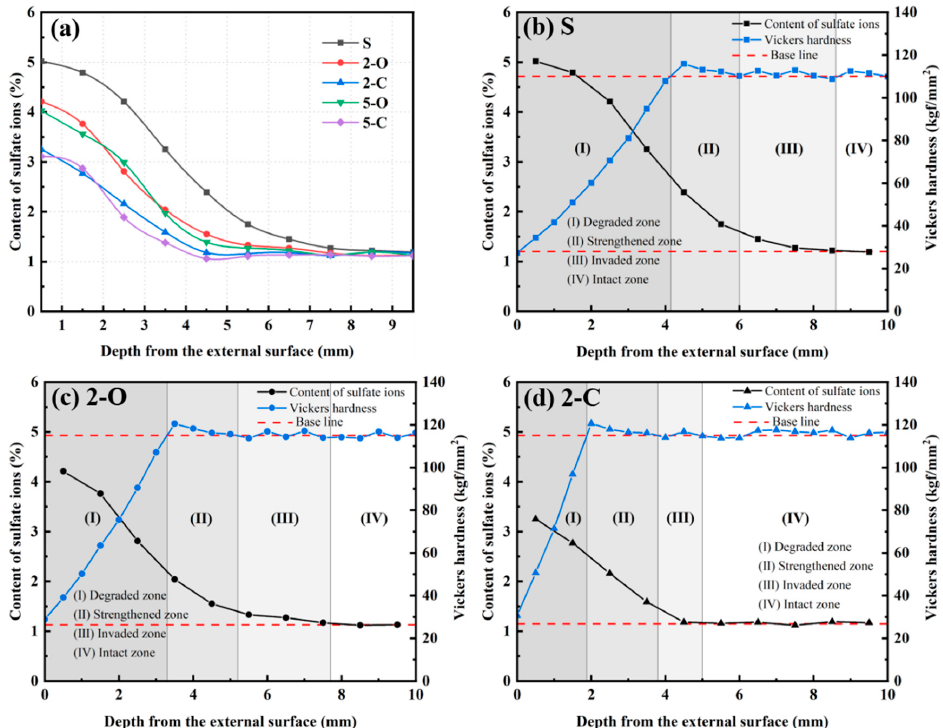
Figure 11. The SO 42 − content of cement paste under sulfate attack (a: all specimens; b: the S speci- men; c: the 2-O specimen; d: the 2-C